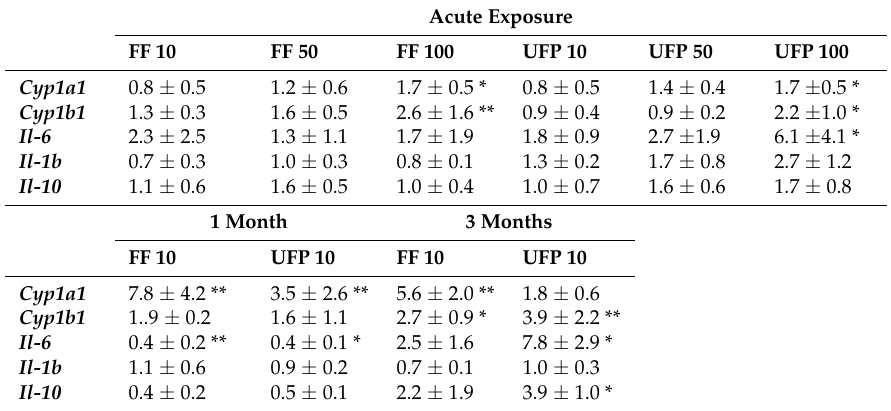
Table 3. Lung mRNA analysis of Cyp1a1, Cyp1b1, Il-6, Il-1b and il-10 in mice exposed to FF or UFP for 24h, 1 month or 3 months.